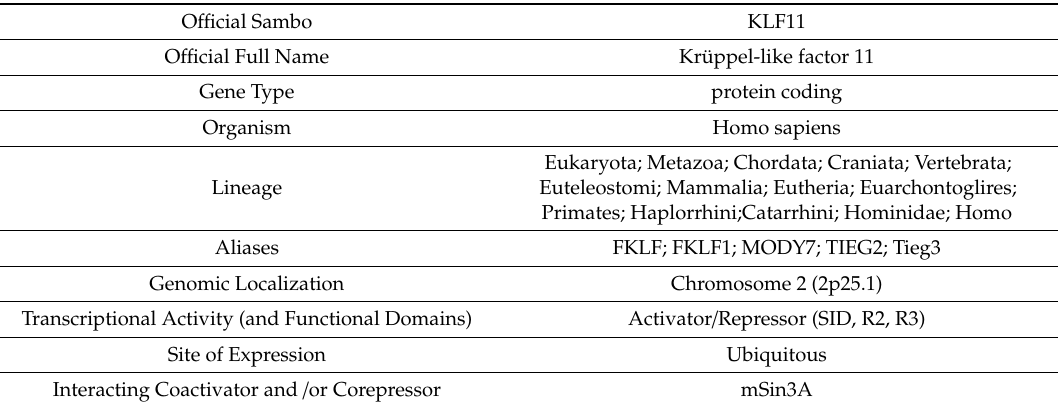
Table 1. Genomic information and aliases of human Krüppel-like factor 11